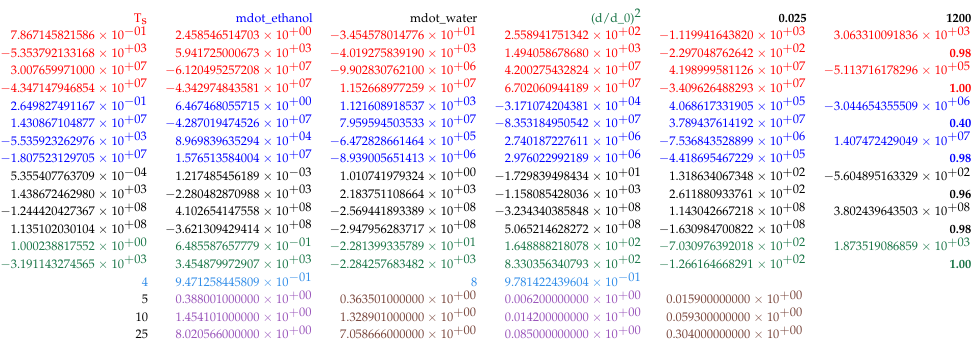
Table 1. Tabulated data of polynomial coefficients for normalized parameters as well as droplet evaporation and thermal decomposition times for different initial conditions at T g,0 = 1200 K and Y INN,0 = 0.025.